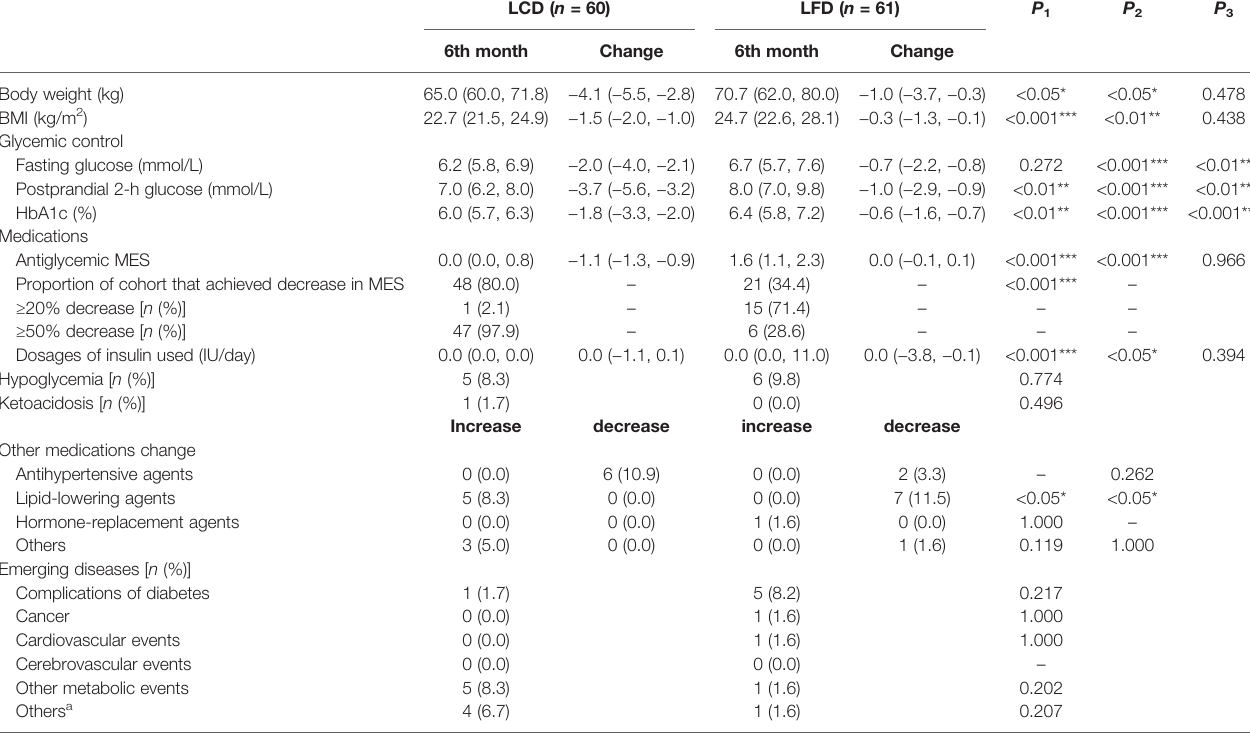
TABLE 4 | Changes in all endpoints after 6 months of